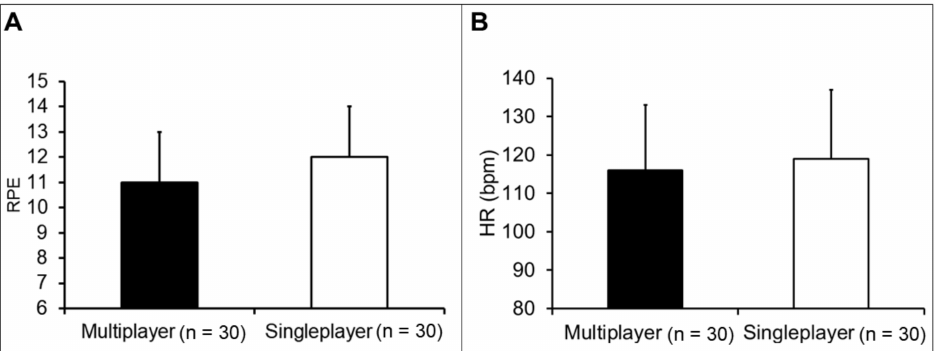
Figure 4. Exercise intensity and exergame. ( A ) Comparison of the RPE between the single